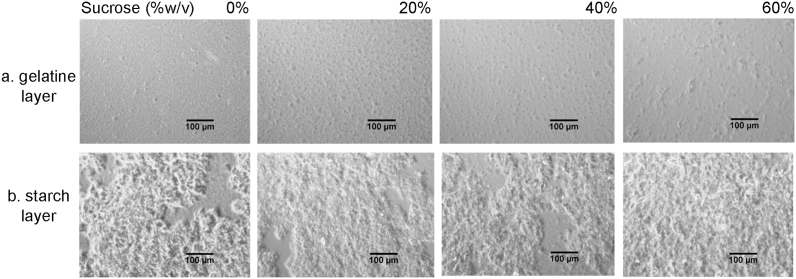
Effects of sucrose on microstructure of the gelatine (a) and starch (b) phase separated layers, gelatine = clear region, starch = aggregated structure.